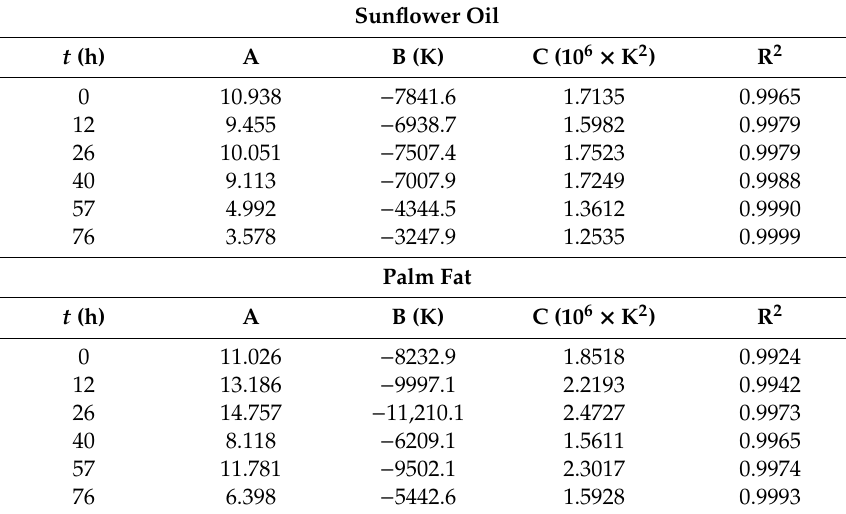
Table 2. Mathematical description of the viscosity η as a function of temperature. Fit parameters of the + C function ln η = A + B for sunflower oil and palm fat. T T 2